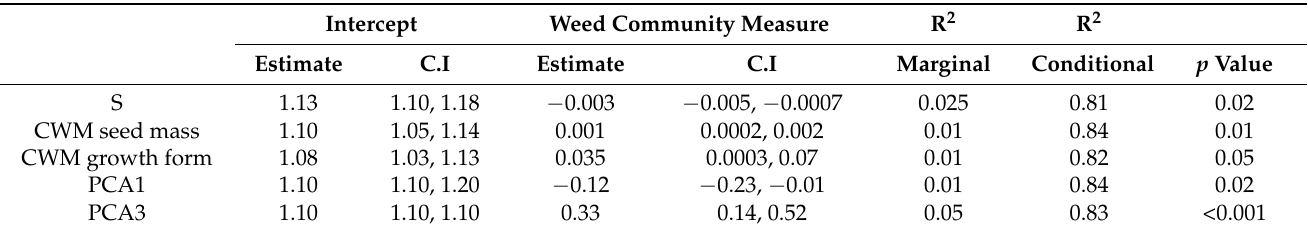
Table 2. Summary of mixed-effects models on the relationship between protein concentration in wheat grains and weed community structure measures. Estimates, confidence intervals (C.I.), p values and R 2 marginal and conditional values of each of the models for which the measure of weed community structure was statistically significant are shown. Intercept Weed Community Measure R 2 R